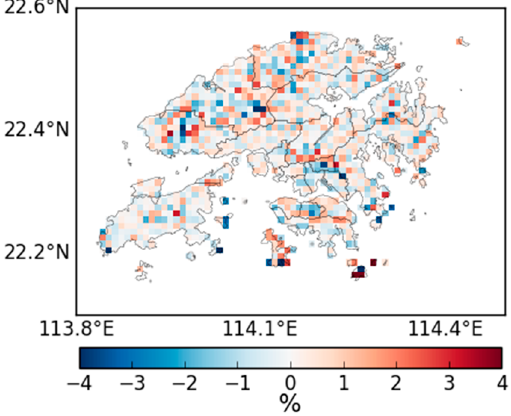
Figure 10. Spatial distribution of the one-grid PM 2.5 change over Hong Kong.